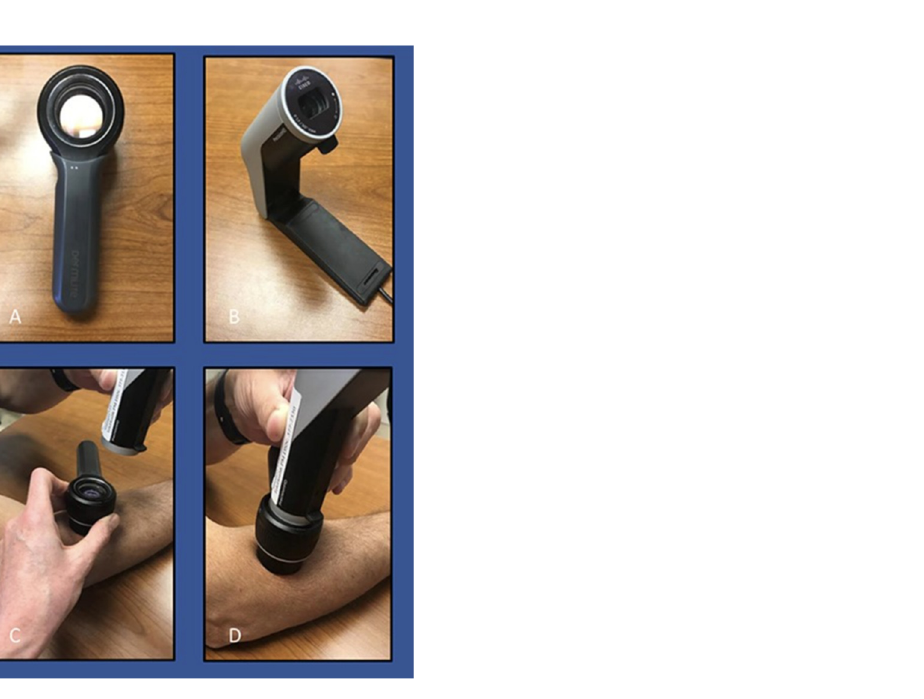
Figure 2. Synchronous teledermoscopy protocol tested at a military training facility. Basic configuration for teledermoscopy. (A) Dermatoscope; (B) Cisco Jabber Webcam; (C) Sanitize dermatoscope and skin lesions with alcohol; (D) Gentle contact between webcam and dermatoscope [11].